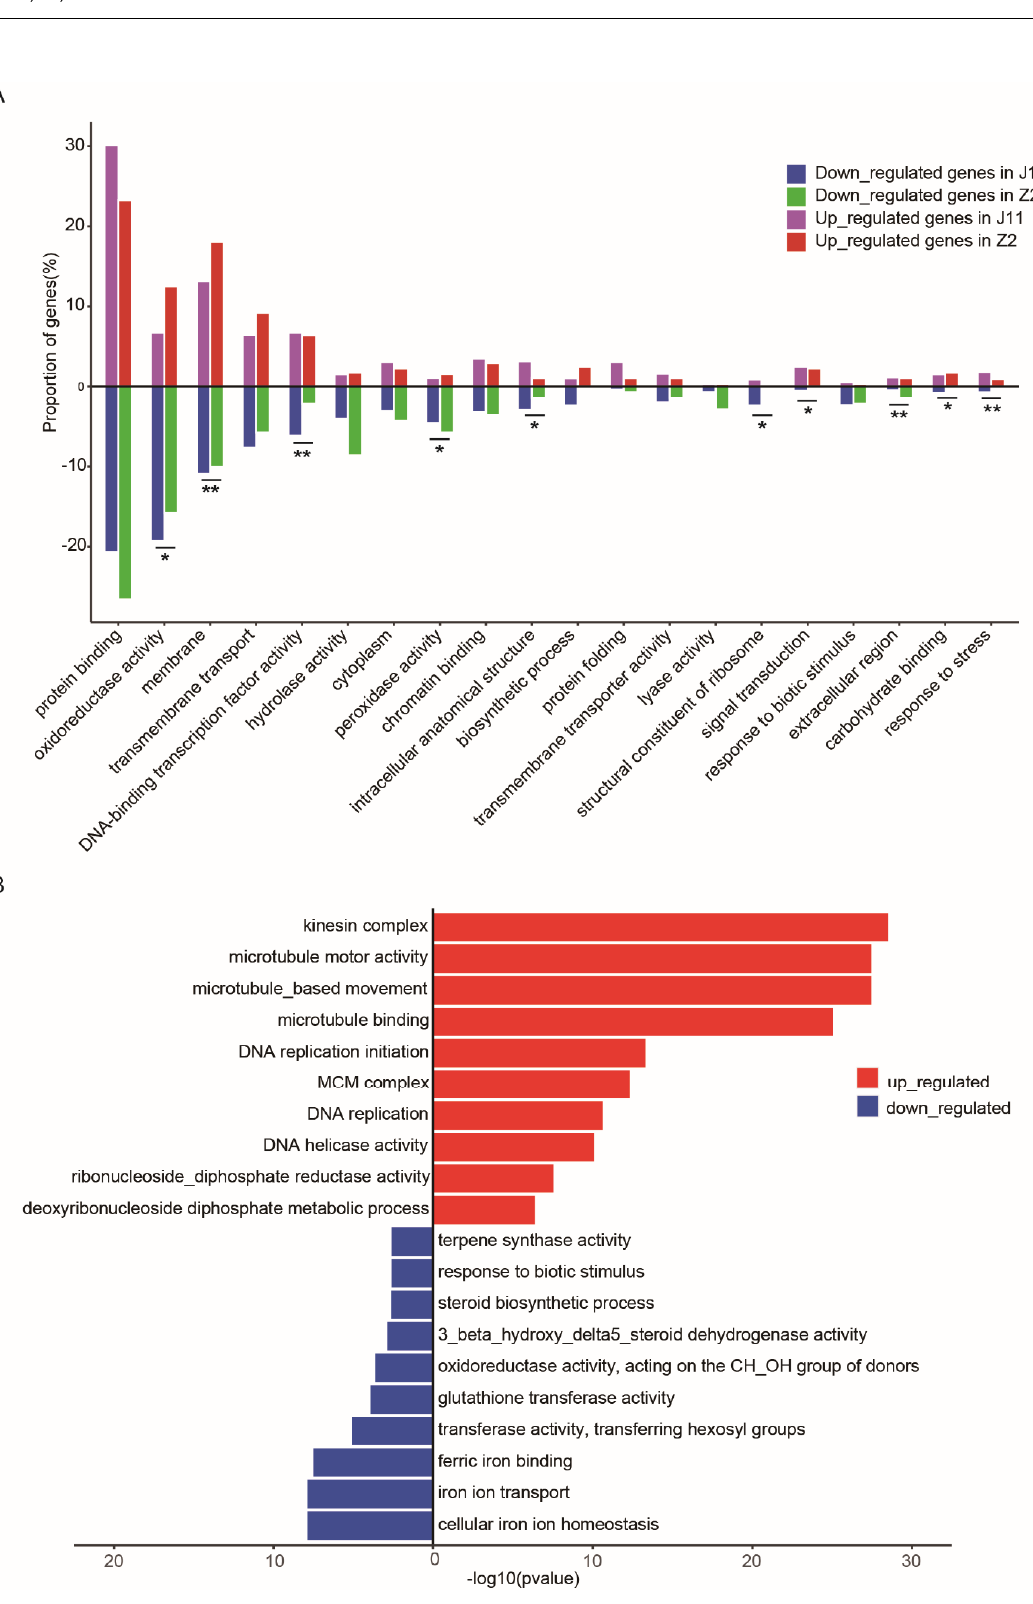
Figure 2. Overview of genes differentially expressed in response to V. dahliae stress in J11 and Z2. ( A ). Functional categories of DEGs after V. dahliae inoculation. The percentages of upregulated and downregulated genes are shown for the selected overrepresented functional categories. The significance of the difference between two accessions (chi-squre test) are analyzed with “*” ( p < 0.05) or “**” ( p < 0.01). ( B ). GO enrichment analysis of the co-upregulated and co-downregulated unigenes with the top10 are shown.